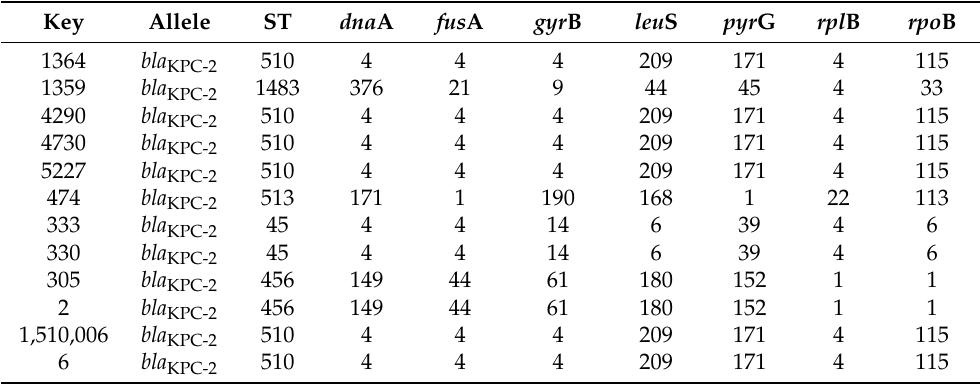
Table 2. Genetic relationship of E. cloacae complex isolates carrying the bla KPC variant.